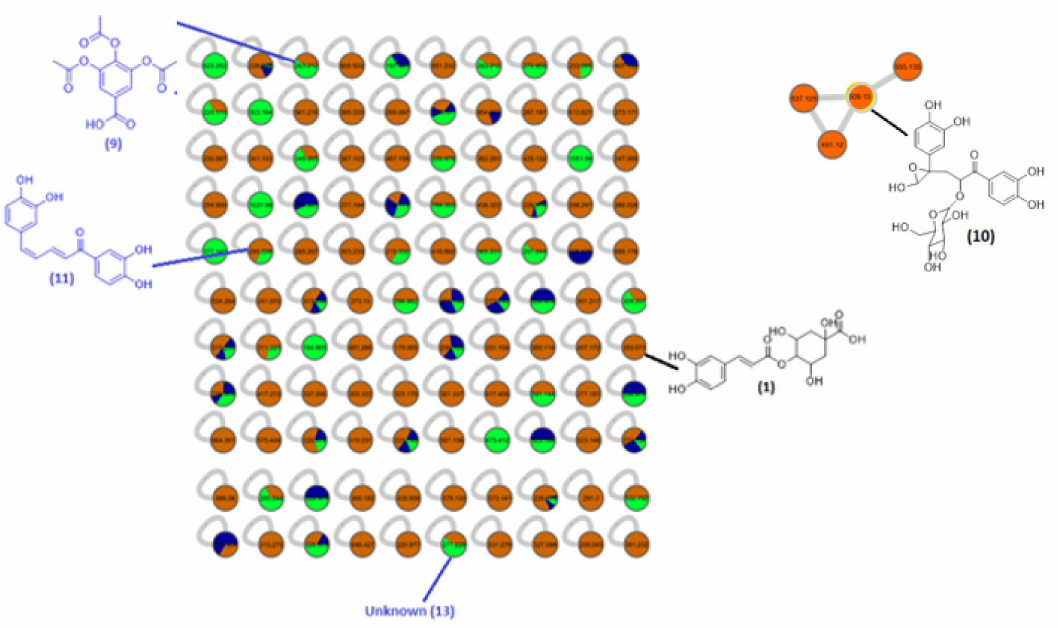
Figure 3. Annotation of the molecular networking of the norlignans and phenolic glycoside derived from Curculigo latifolia rhizome and leaf extracts, obtained from the GNPS library and PubChem platforms. The black colored structures ( --- ) are from the rhizome extract and blue color structures ( --- ) are from the leaf extract.